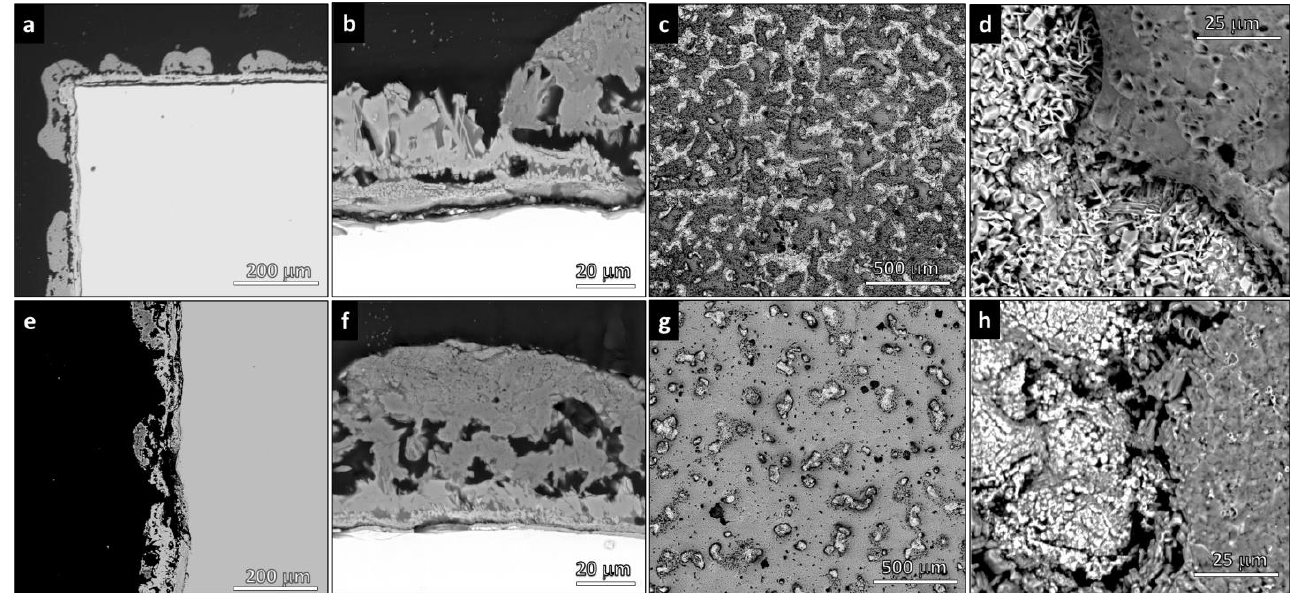
Figure 5. Microstructural details of cross-section and surface of V2A glass – ceramic coatings: ( a – d ) 1.5 s; ( e – h ) 3 s. ( a – d ) 1.5 s; ( e – h ) 3